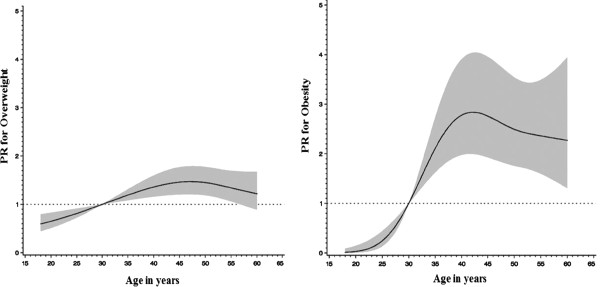
The prevalence of obesity and overweight in relation to age.